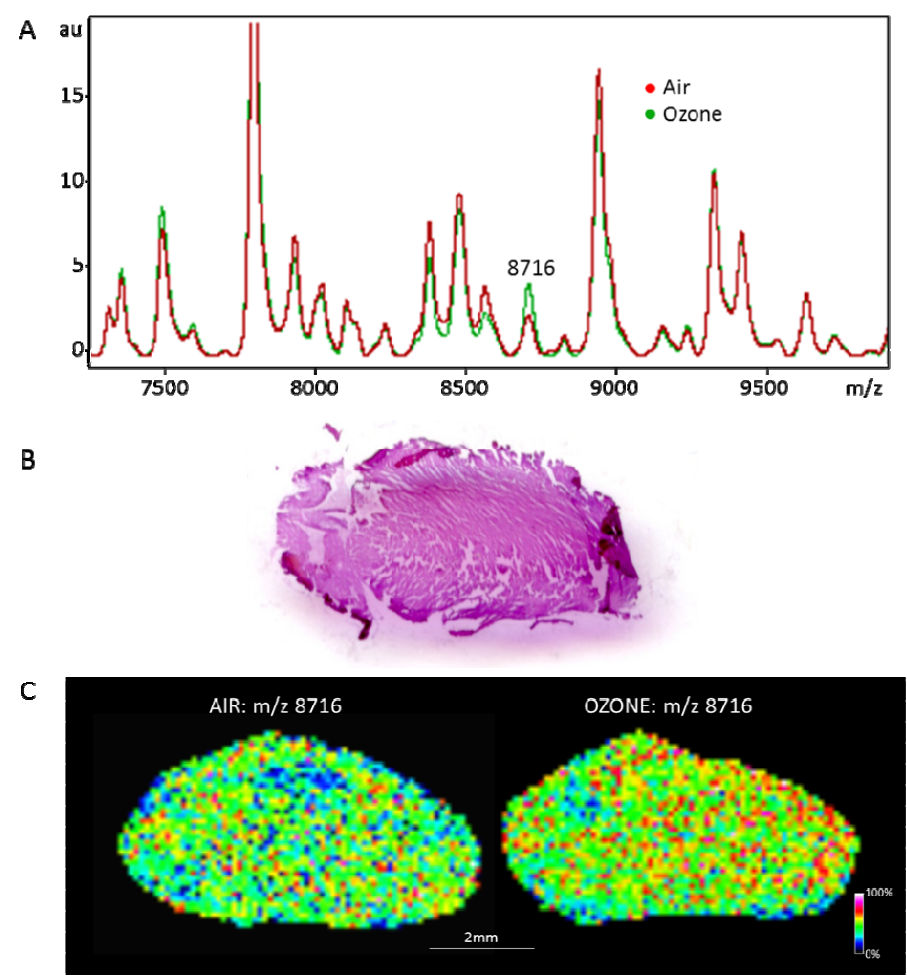
Figure 2. Normalized (to the total ion count) average MALDI-TOF mass spectra ( A ), histology data ( B ) and normalized mass spectral images (UltrafleXtreme, Bruker™) of heart sections ( C ) from ApoE-/- mice exposed to air (controls) and 0.8 ppm ozone (treatment). Frozen heart sections (12 μ m thickness) on indium tin oxide (ITO) coated slides were prepared in triplicate for mice from control and treatment groups ( n = 4/group) for MSI analysis. Sinapinic acid was used as the matrix and was spray coated on the dried tissue section (Bruker ImagePrep) for imaging. Detection was in a linear positive mode. Lateral resolution for imaging was 100 μ m. One of the analyte peaks among those that were significantly different ( p < 0.05) with ozone treatment compared to the control group was tentatively assigned as small-inducible cytokine B10 ( m / z